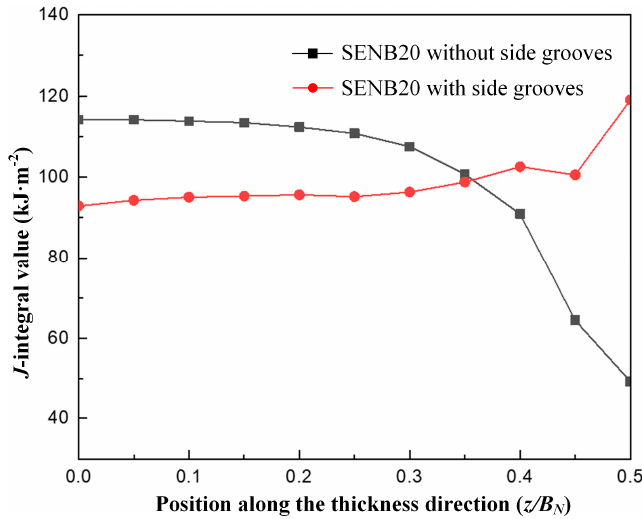
Figure 12. J -integral distribution of the specimens SENB20 without and with side grooves along the thickness direction.